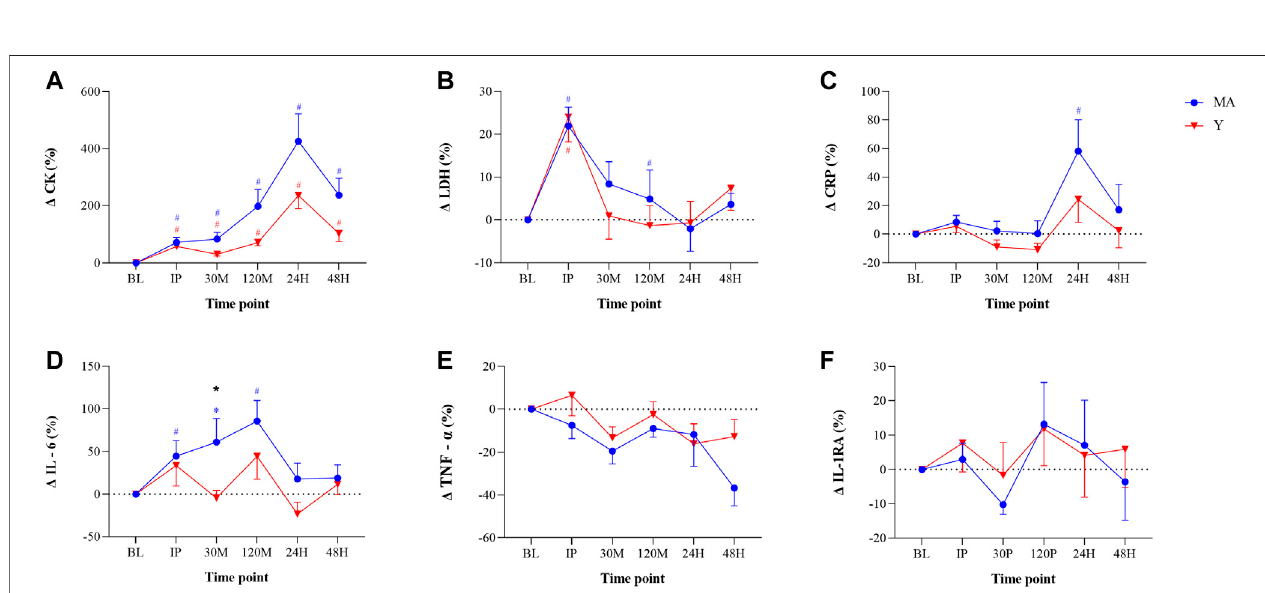
FIGURE 4 | Changes in blood markers of muscle damage and in fl ammation: Creatine kinase [CK; panel (A) ], Lactate dehydrogenase [LDH; panel (B) ], C-reactive protein [CRP; panel (C) ] Interleukin-6 [IL-6; panel (D) ], Tumor necrosis factor- α [TNF- α ; panel (E) ], and IL-1 receptor antagonist [IL-1RA; panel (F) ] relative to baseline (BL). Measurements were taken as BL, immediately post (IP), 30 min (30 M), 120 min (120 M), 24 h (24H) and 48 h (48H) following a 60 min downhill running protocol. Young (Y; red triangle) and middle-age (MA; blue circles) groups. Dotted horizontal line represents no change compared to BL. # Signi fi cant ( p < 0.05) difference compared with BL within each group. * Signi fi cant ( p < 0.05) difference between groups at given time point. All data are reported as mean ± SEM.